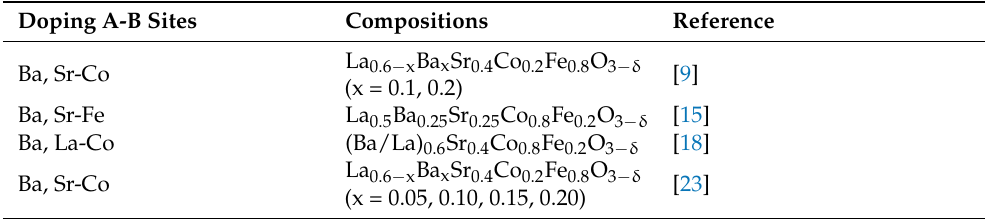
Table 1. List of Ba-doped materials. Doping A-B